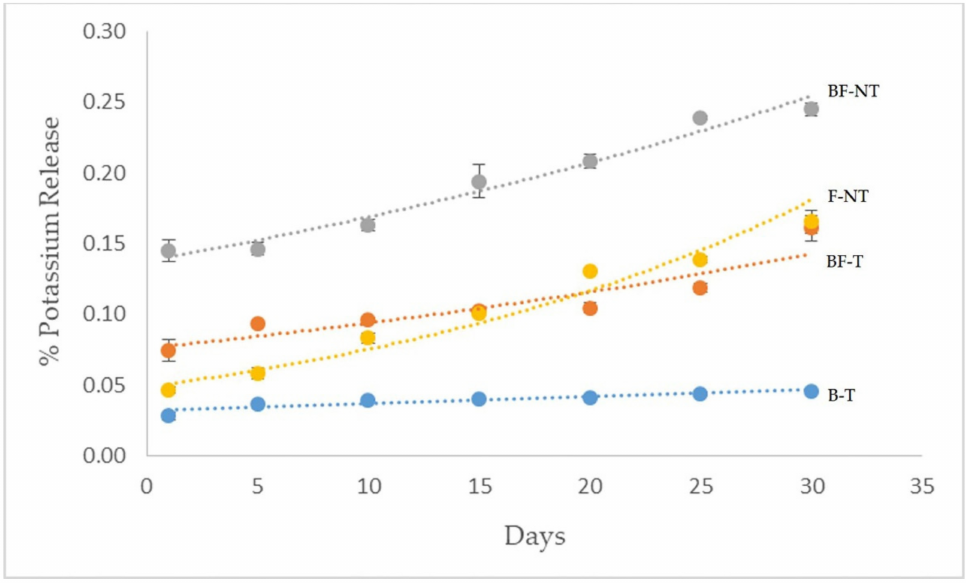
Figure 9. Percent potassium release of total K applied at five day intervals for 30 days of a water incubation